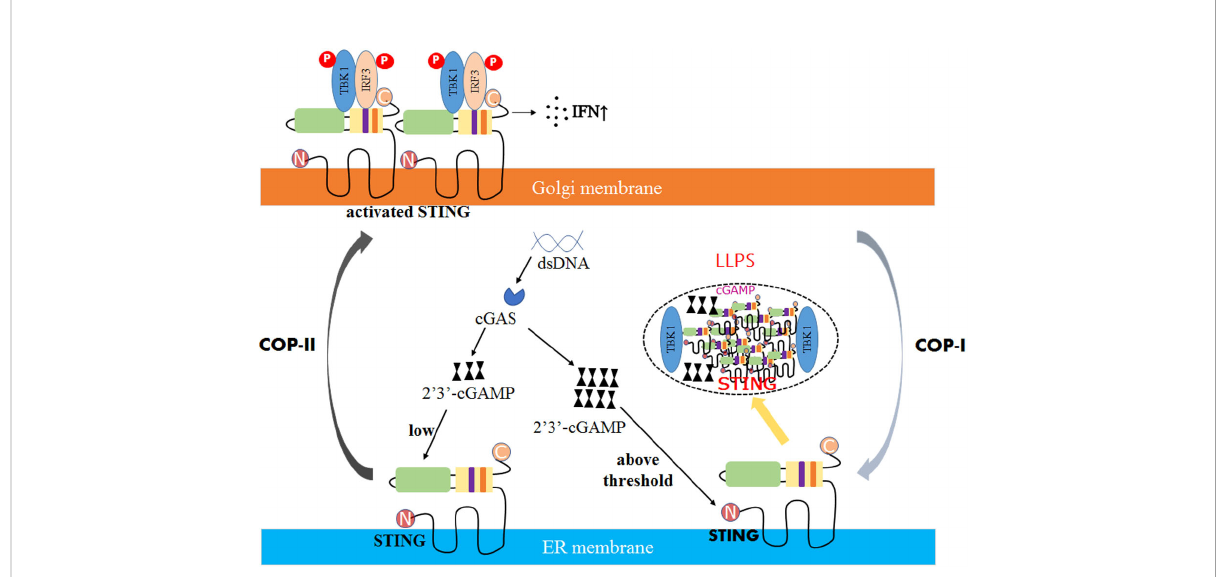
FIGURE 2 The mechanism of STING phase separators interferes with innate immune signaling. In DNA virus-infected cells, the recognition of double- stranded DNA (dsDNA) by STING on the ER membrane is followed by activating the second messenger 2 ′ 3 ′ -cGAMP generated by the DNA sensor cGAS. Due to low levels of 2 ′ 3 ′ -cGAMP, STING is transferred to the Golgi apparatus, polymerized, and recruited to activate TBK1 and IRF3, promoting the production of cytokines such as type I interferon (IFN). However, when the concentration of 2 ′ 3 ′ -cGAMP reaches a threshold, the STING phase separator forms, recruiting cGAMP and unphosphorylated TBK1 into liquid droplets, separating STING and TBK1 from its downstream signaling and preventing the overactivation of the innate immune